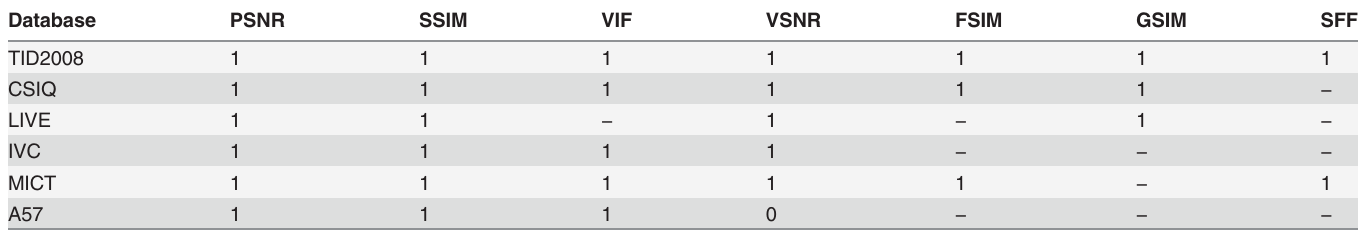
Table 4. Performance comparison based on statistical signi fi cance.